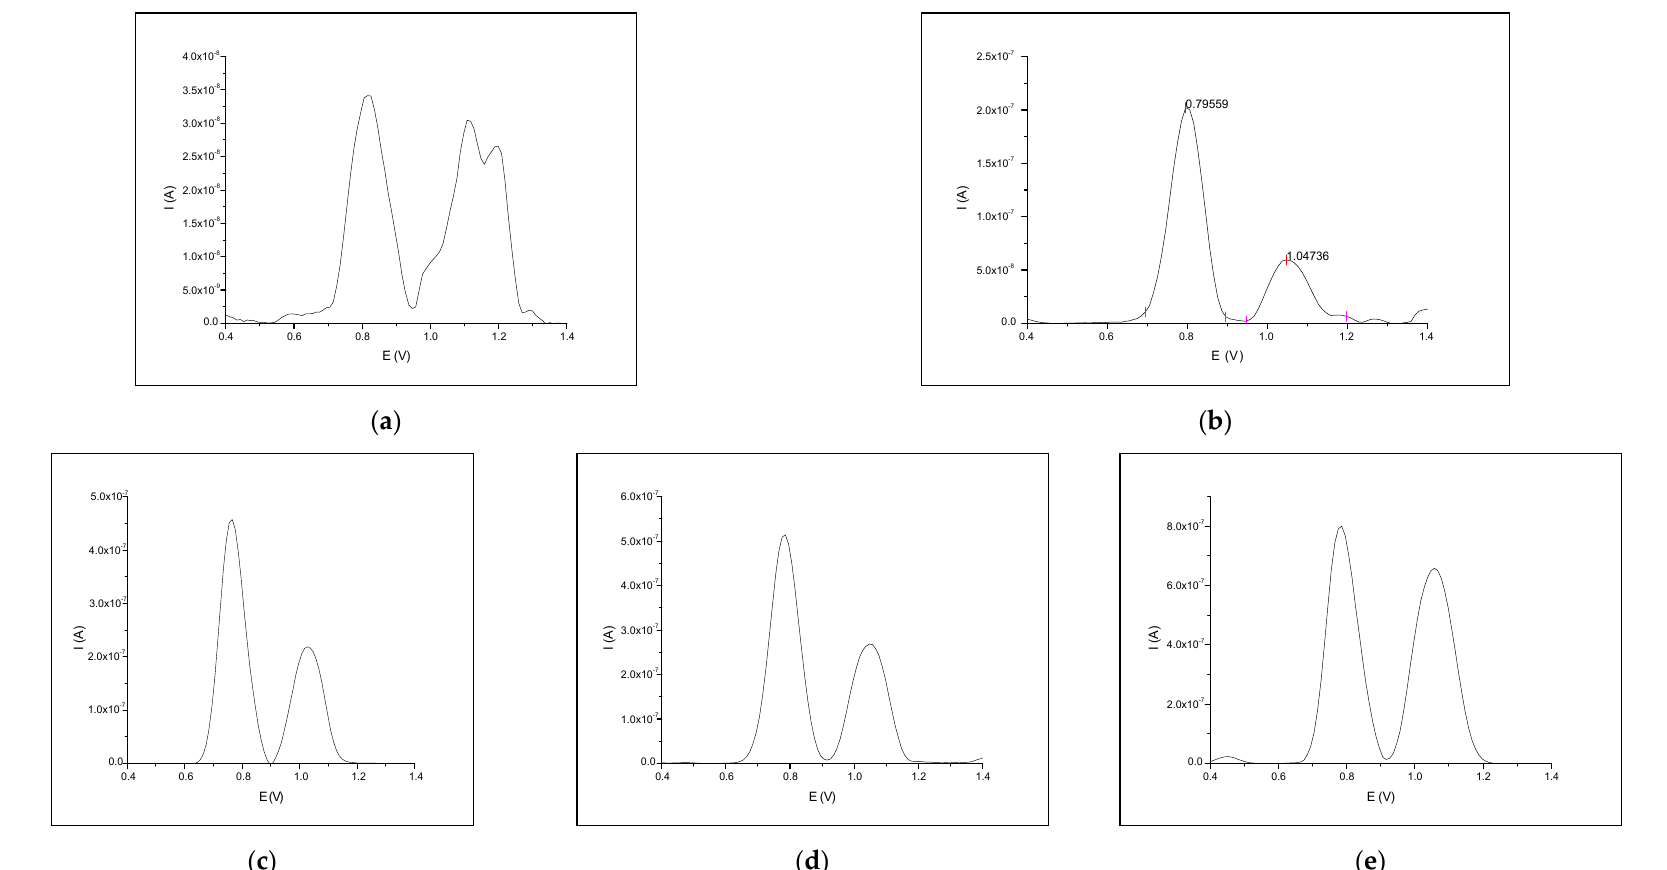
Figure A2. Average voltamperograms of different concentrations of naringin: ( a ) 0.5 μM; ( b ) 2.5 μM; ( c ) 5.0 μM; ( d ) 10.0 μM; ( e ) 20 μM.